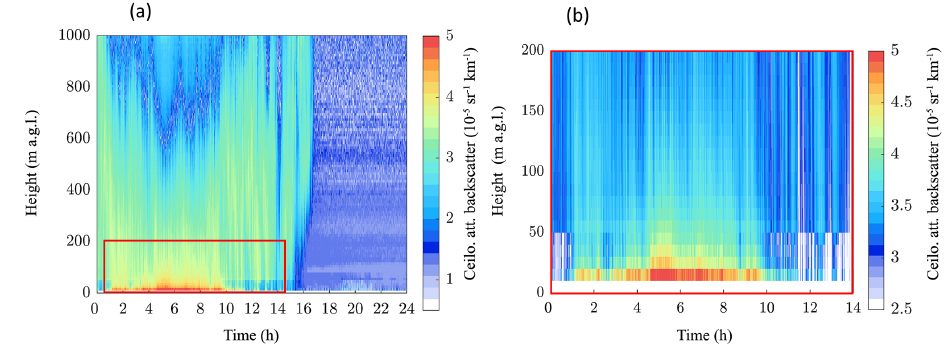
Figure 1. (a) Time ( x axis, in hours) and height ( y axis, ma . g . l . ) cross section of an attenuated backscatter profile for the CL-31 ceilometer at PE station, on 24 April 2016. The color of the profile represents the intensity of the returned backscattered signal at a certain range bin. (b) Zoom of blowing snow between 01:00 and 10:00UTC, denoted by the red and yellow color in the range bins closest to the ground. The artifact discussed in Sect. 3.1. is visible around 50m height.